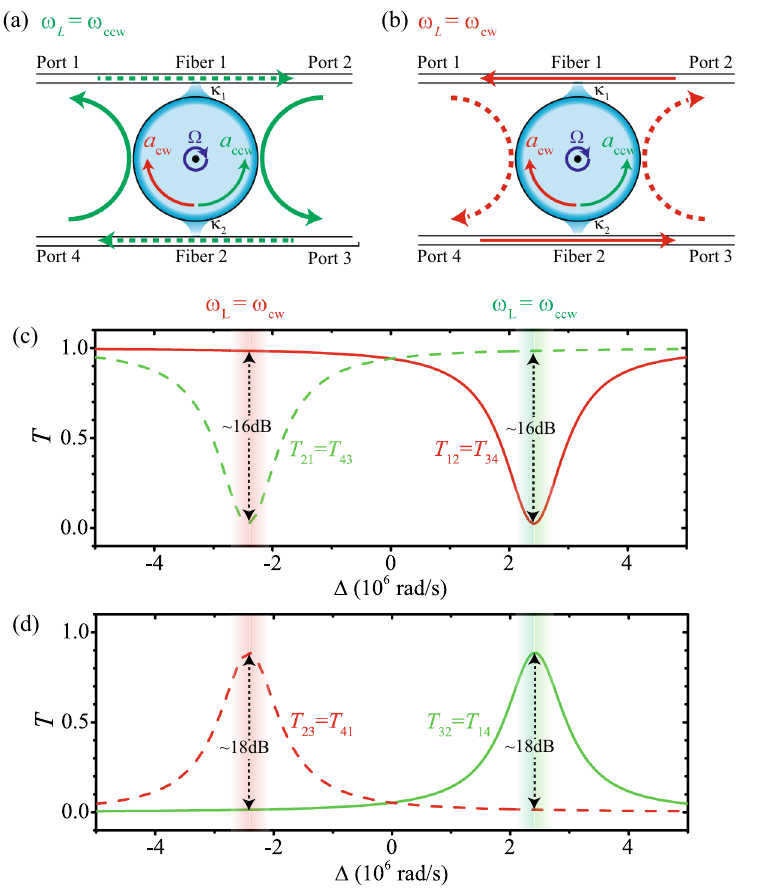
Figure 1. (Color online) Routing behaviors of the circulator for the input field with frequency ( a ) ω